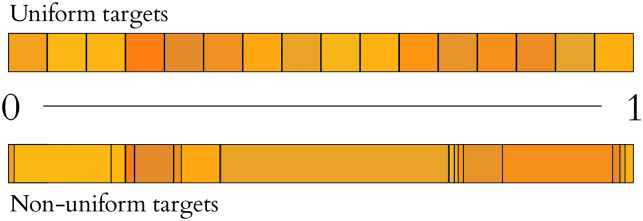
Uniform and nonuniform targets.Subdivision of the unit interval into discrete targets for selection can be performed uniformly (top, corresponding to a flat prior over targets), or according to some known prior distribution π(si) (bottom).